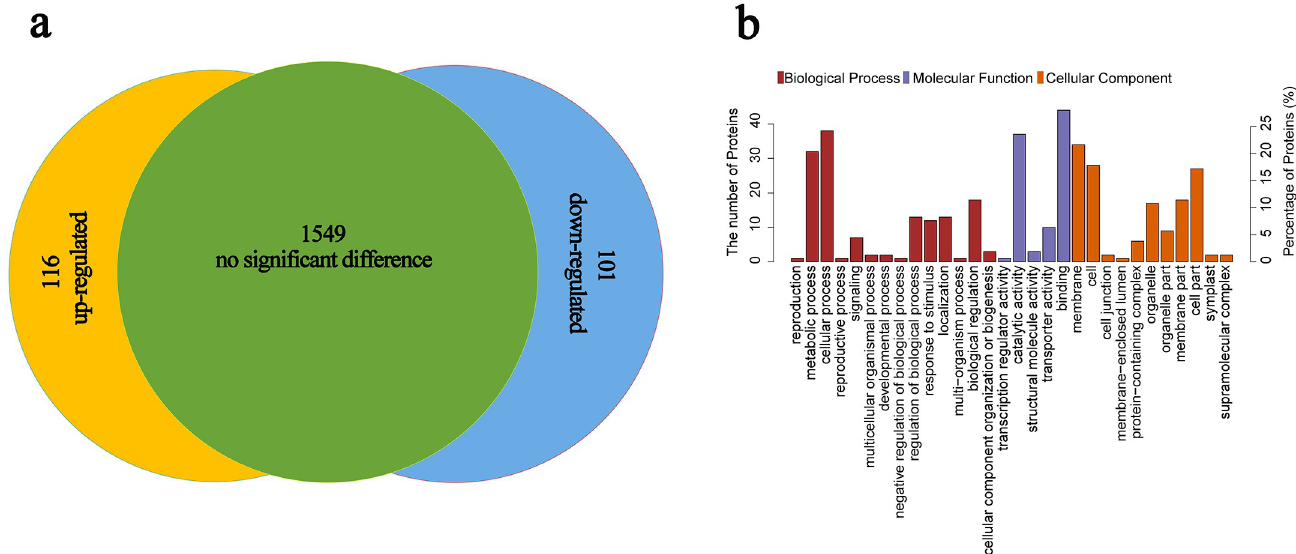
Fig 2. Distribution and ClueGO analysis of differential phosphopeptides in lettuce under high-temperature treatment. (a) Distribution analysis of differential phosphopeptides and ( b ) GO annotation for molecular function, biological process, and cellular component pathways.